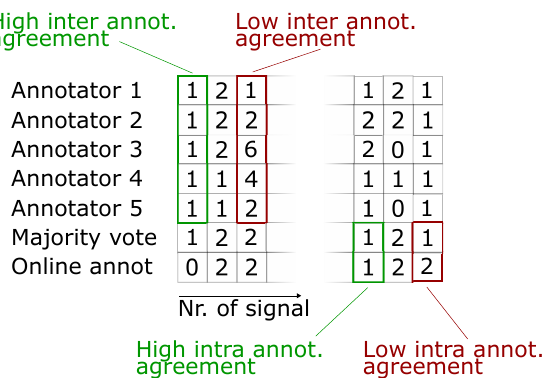
Figure 2. Explanation of measures for inter-annotator agreement and intra-annotator